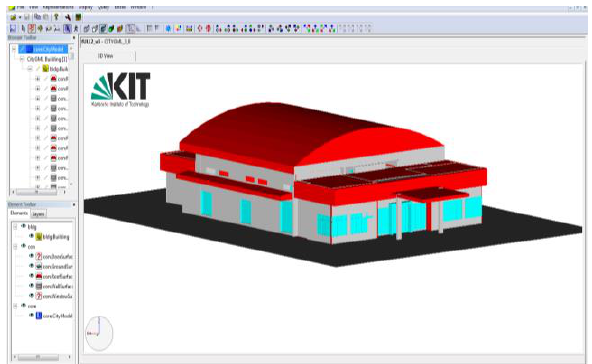
Figure 7. Dewan Muafakat Taman Kobena CityGML 3.0 representation